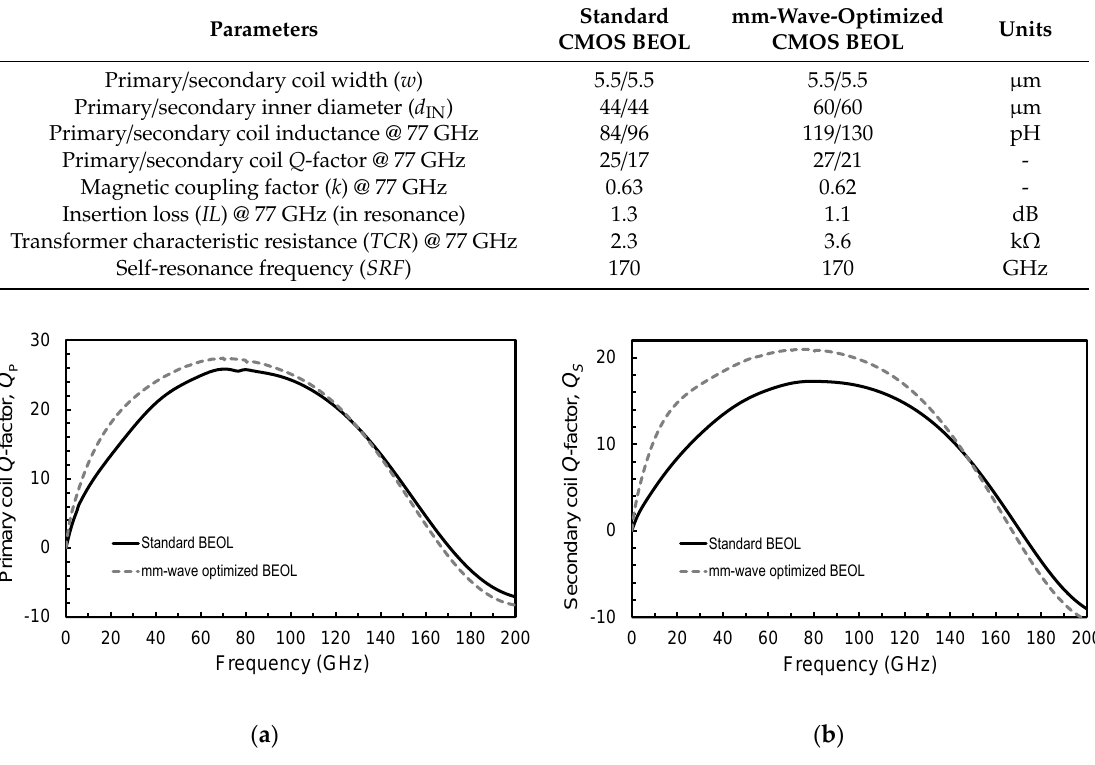
Table 1. Geometrical and performance parameter comparison for the stacked transformer T 1 .